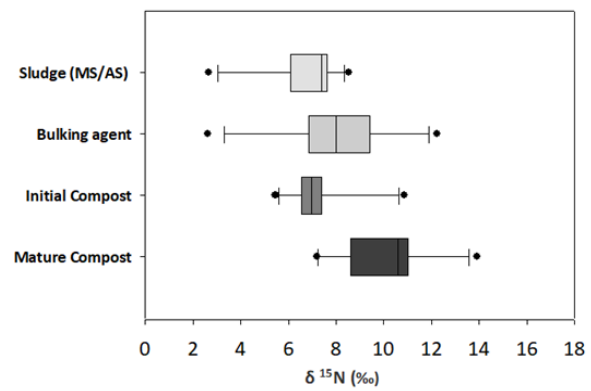
Figure 3. Natural δ 15 N values (‰) in the initial materials, initial composting mixtures and mature composts. The vertical lines of rectangles represent the lower and upper quartiles of distributions. The middle lines inside the rectangles represent median values.